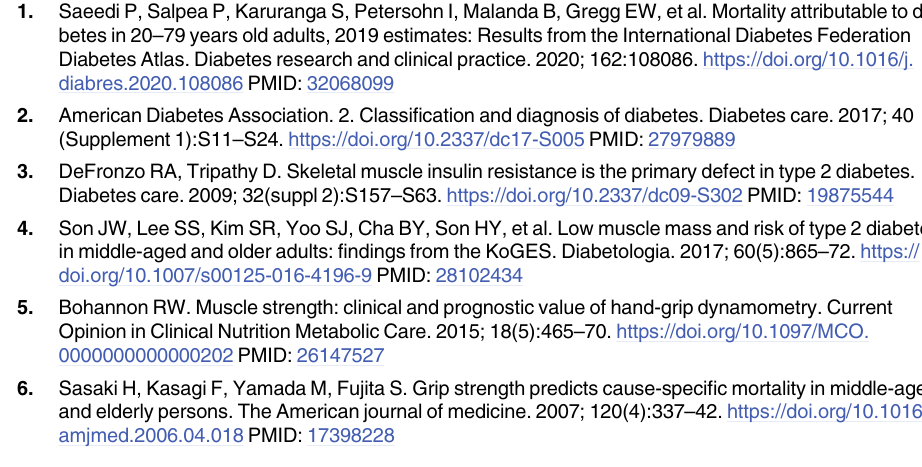
S2 Table. Odds ratios of T2DM by quintiles of grip strength divided by body mass index. S3 Table. Odds ratio of prevalence of type 2 diabetes mellitus, stratified by relative grip strength in